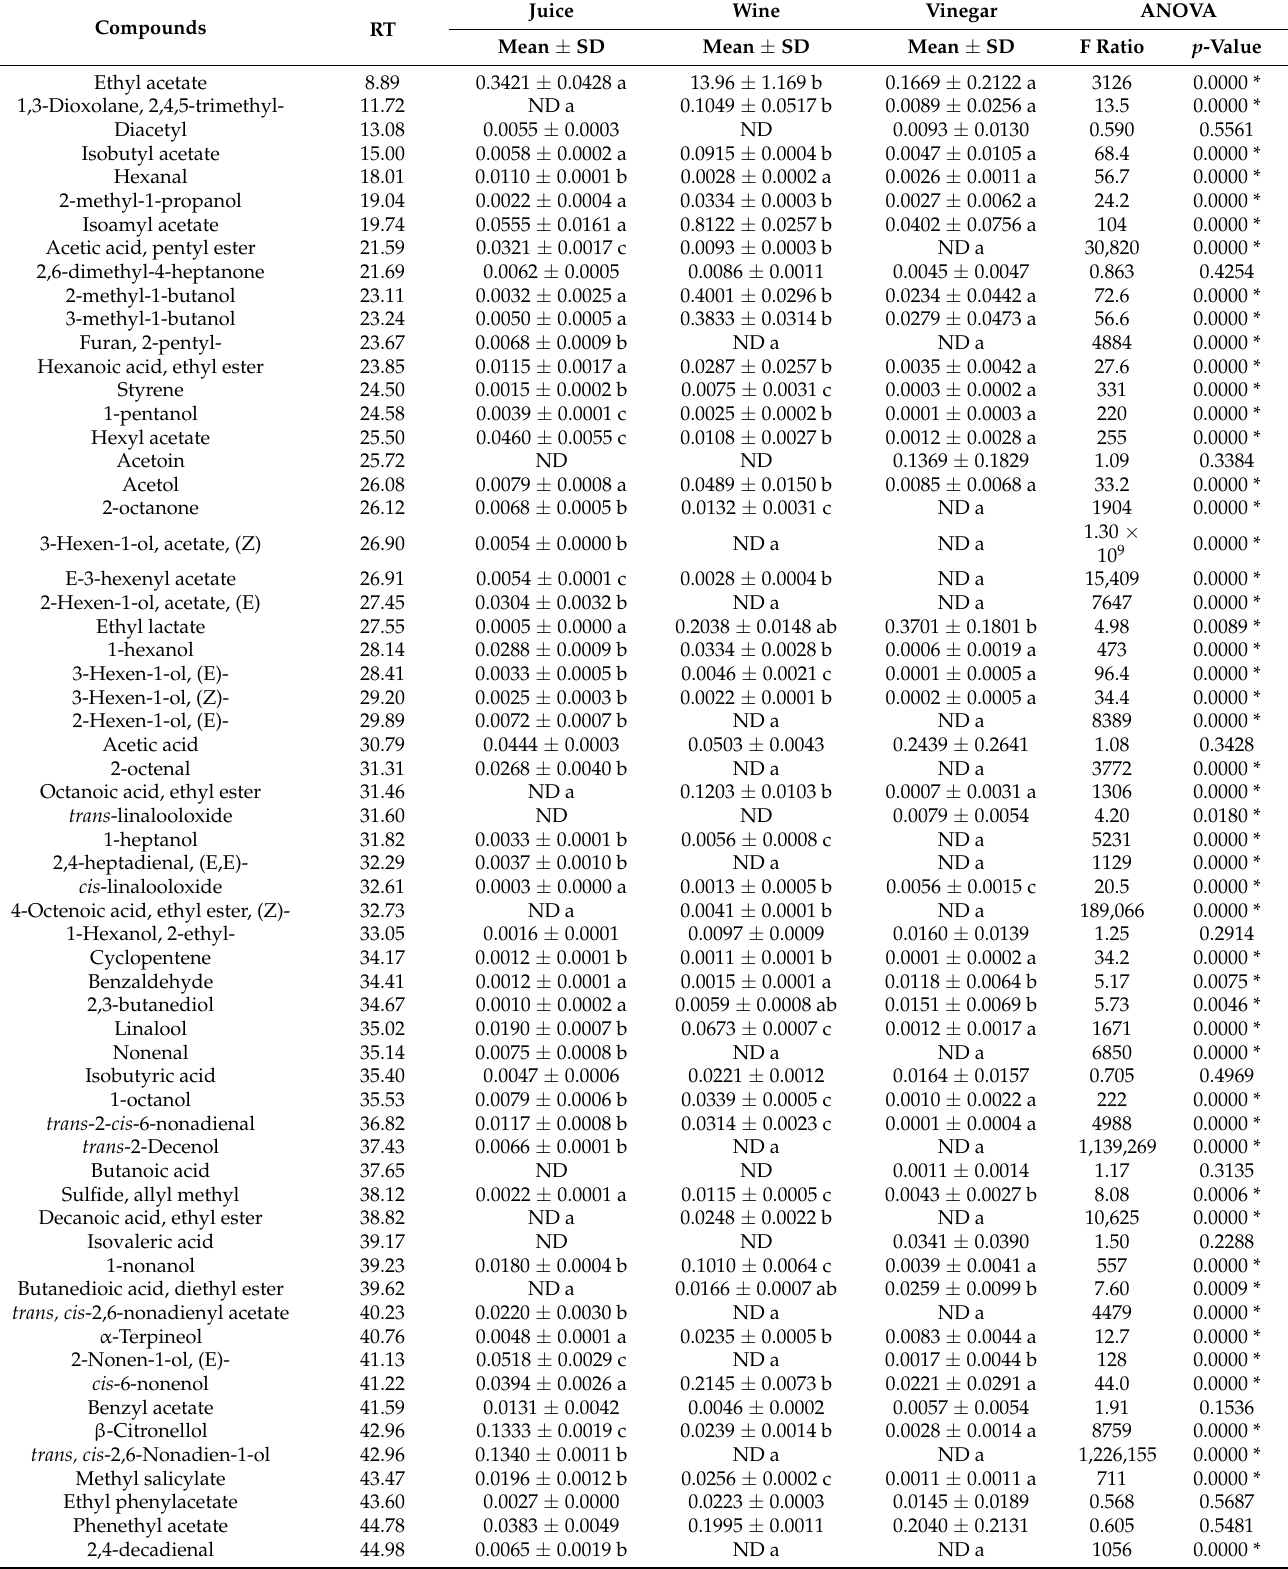
Table 1. Retention times (RT), mean relative areas and standard deviations (SD) of volatile compounds identified by SBSE-GC-MS in different prickly pear matrices (juice, wine, vinegar). Results of analysis of variance taking into account the